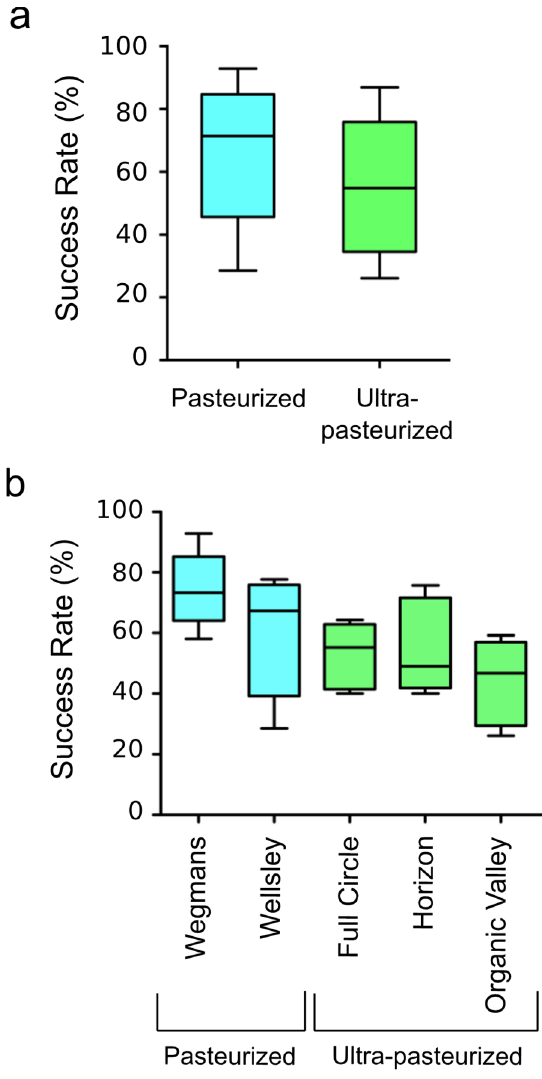
Figure 1. Success rates in identifying milk samples by treatment type and brand. ( a ) Box plots showing the distribution of participant success in correctly identifying pasteurized (blue: Wegmans and Wellsley Whole Milk) and ultrapasteurized (green: Organic Valley, Horizon, Full Circle Whole Milk) samples. Successful identification by study participants was statistically significant for pasteurized ( p < 0.05 ), but not for ultrapasteurized milk samples. ( b ) Box plots showing the distribution of participant success in correctly identifying the two brands of pasteurized milk (blue; Wegmans and Wellsley Whole Milk) and the three brands of ultrapasteurized milk (green; Organic Valley, Horizon and Full Circle Whole Milk). The pasteurized Wegman’s Whole Milk ( p = 0.0002) was the only brand that study participants could identify with significance ( p < 0.05 ). Table 1. Mean success rate in identifying pasteurized and ultrapasteurized milk